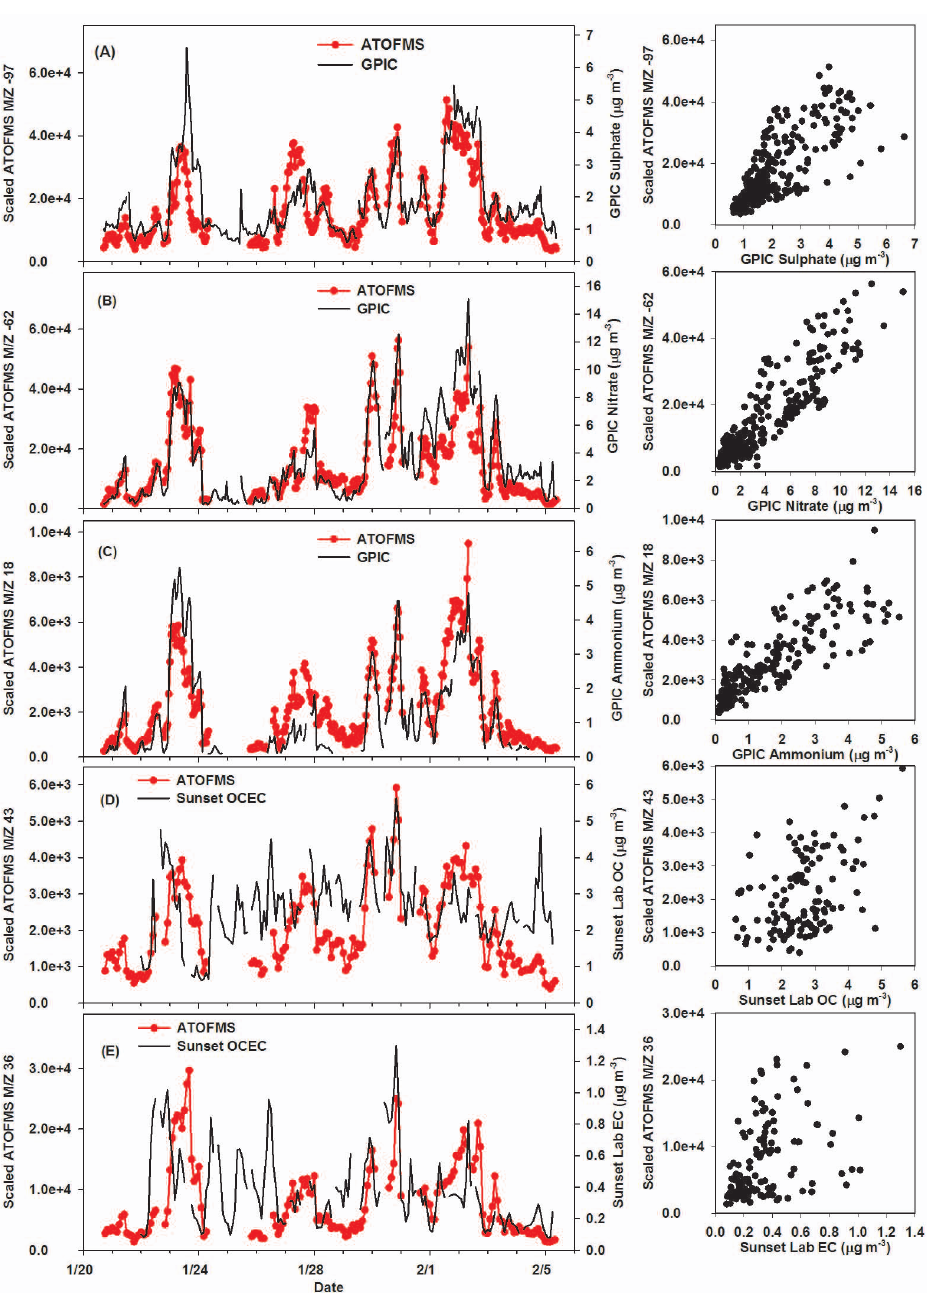
Fig. 4. Comparison between total ATOFMS relative peak area scaled by particle transmission efficiency and corresponding GPIC measure- ments as well as Sunset Lab OC and EC concentrations during the SPORT campaign in Toronto. (A) sulphate, (B) nitrate, (C) ammonium, (D) OC, and (E)